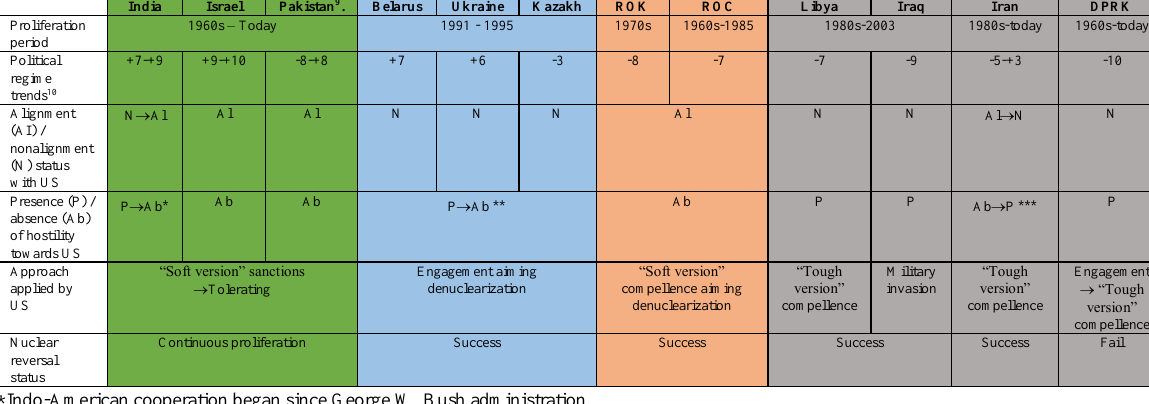
Table 1. Reaction of the US Government to Nuclear Programs